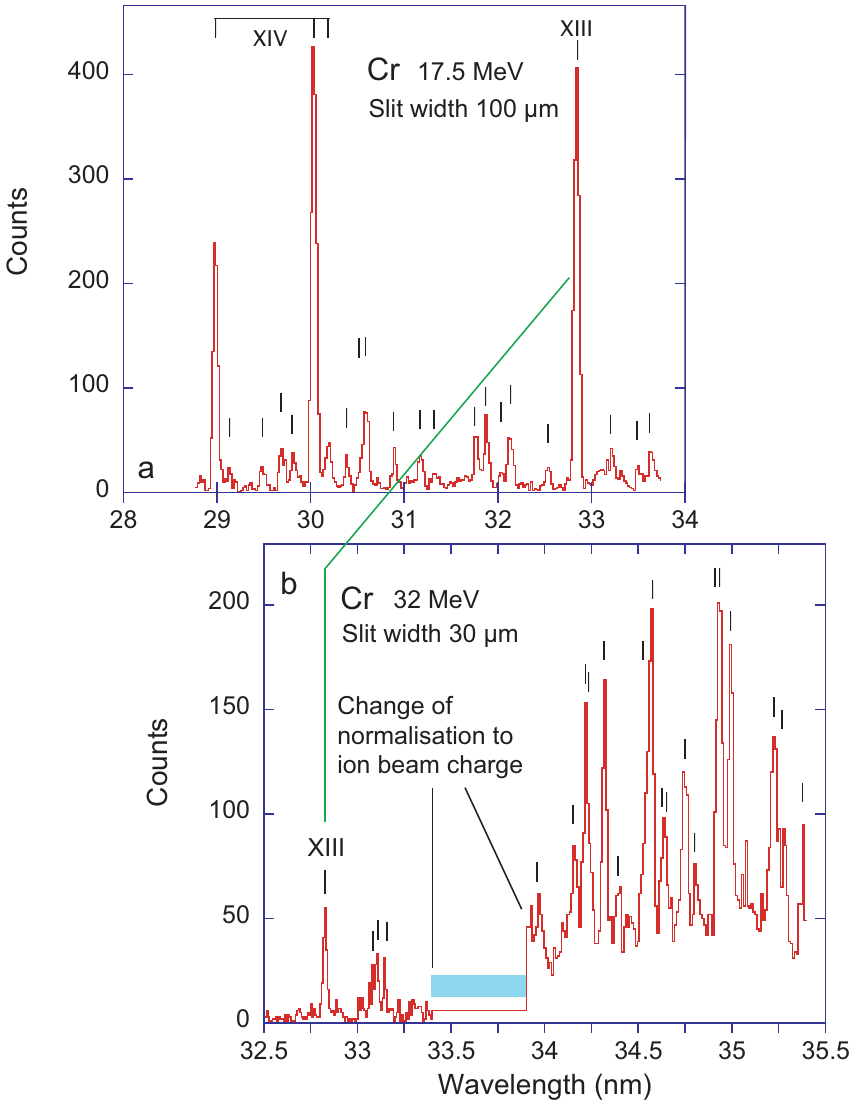
Figure 16. Beam-foil spectra of Cr observed at the foil. ( a ) Spectrum recorded at an ion beam energy of 17.5MeV. Line width (FWHM) 0.075nm. ( b ) Spectrum recorded at an ion beam energy of 32MeV and at a higher resolution (Line width (FWHM) 0.025nm). Fiducials mark a fair number of other lines in both spectra. The strongest known lines are identified by the spectrum number. The green line connects the same CrXIII 3s 2 1 S 0 –3s3p 1 P o reference line in the two spectra. The horizontal blue 1 bar indicates a gap between recordings. The weak lines in spectrum ( a ) can largely be identified from the literature, whereas the weak lines in spectrum ( b ) remain